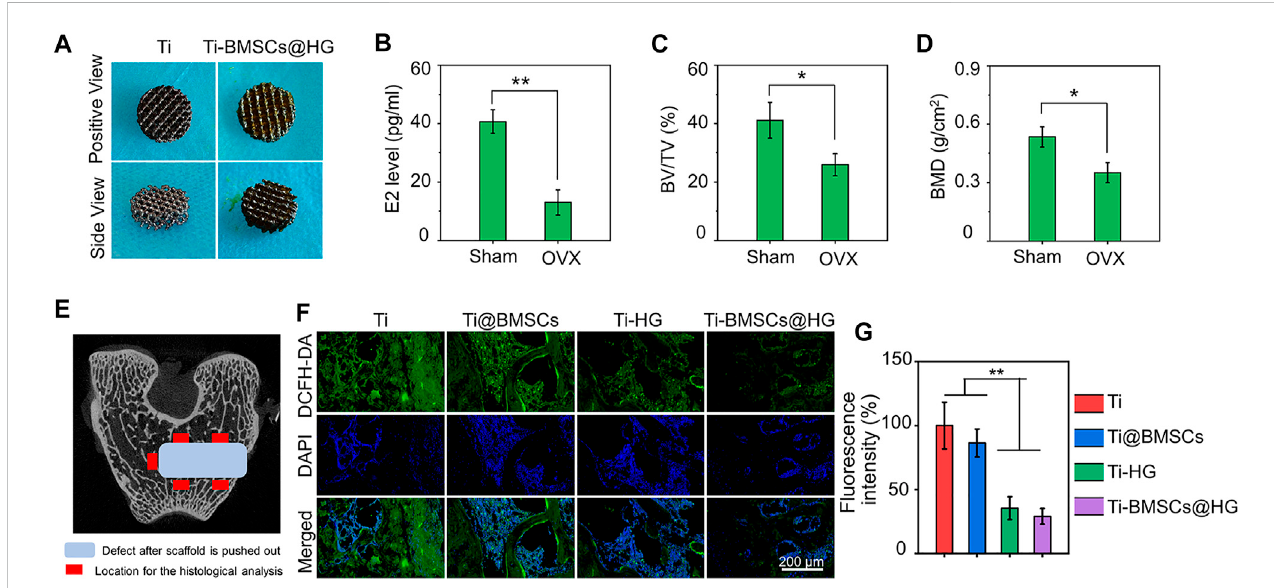
FIGURE 6 (A) Gross images of 3D printed porous titanium alloy prosthesis and rBMSCs-loaded hydrogel fi lled porous prosthesis. (B) Serum estrogen (E2) concentrationsofrabbitmodel8 monthsafter OVX. (C) Quantitativeanalysis ofBV/TV8 monthsafter OVX byMicro-CTscanning. (D) Quantitativeanalysis of BMD 8 months after OVX by Micro-CT scanning. (E) The schematic picture of the location for the histological analysis. (F) ROS-scavenging around the interface2 weeksafterprosthesisimplantationwasdetectedbyaROSprobe(DCFD-DA). (G) Quanti fi cationofthe fl uorescenceintensityofDCFD-DAin bone samples (* p < .05 and ** p <